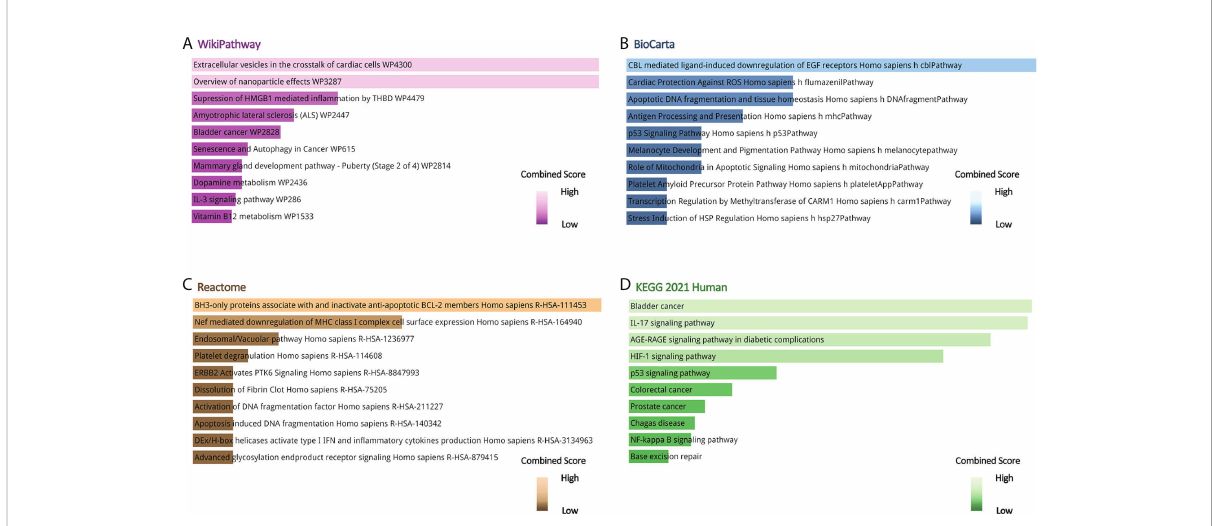
FIGURE 4 Pathway enrichment analysis of common genes between long COVID and ME/CFS. (A) Wikipathway, (B) BioCarta Pathway, (C) Reactome Pathway, (D) KEGG Human